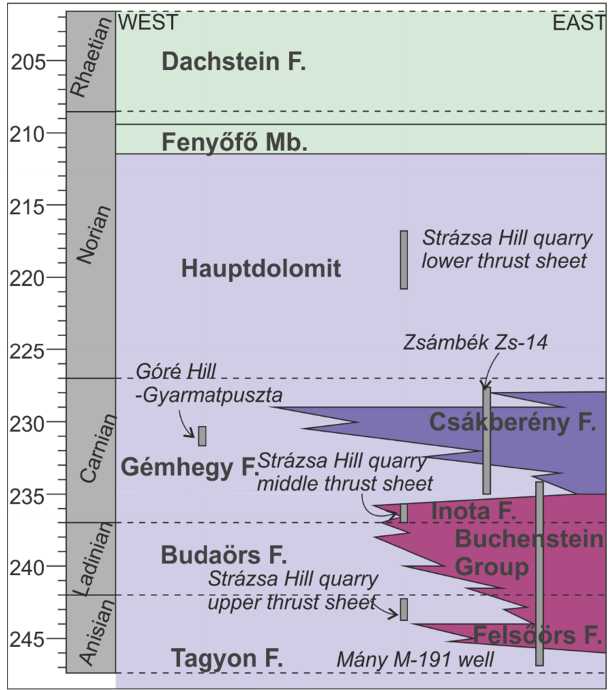
Figure 3. Stratigraphy of the Triassic basement of the study area. Light lilac and pale green colors indicate the dolomitized and partly or non-dolomitized competent platform carbonates, respectively. Purple and dark lilac colors indicate the weak Anisian–Early Carnian and Carnian intra-platform basin deposits, respectively. Grey columns indicate the stratigraphic position of key outcrops/wells [33–37].